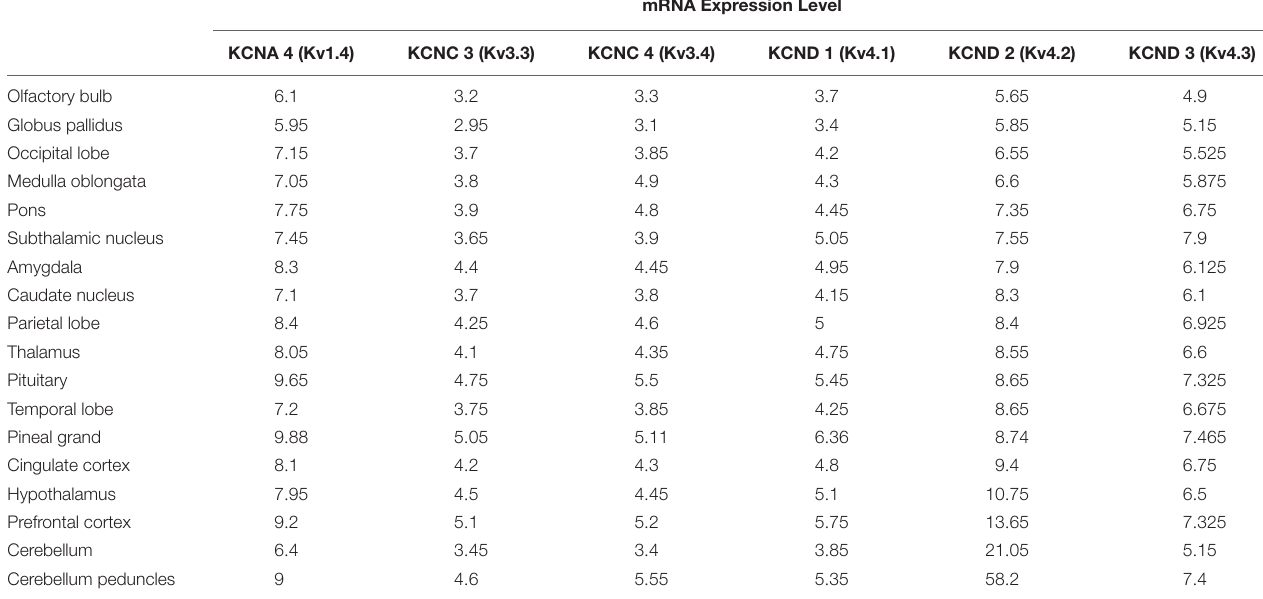
TABLE 1 | mRNA expression levels of each I A channel subunit on the human